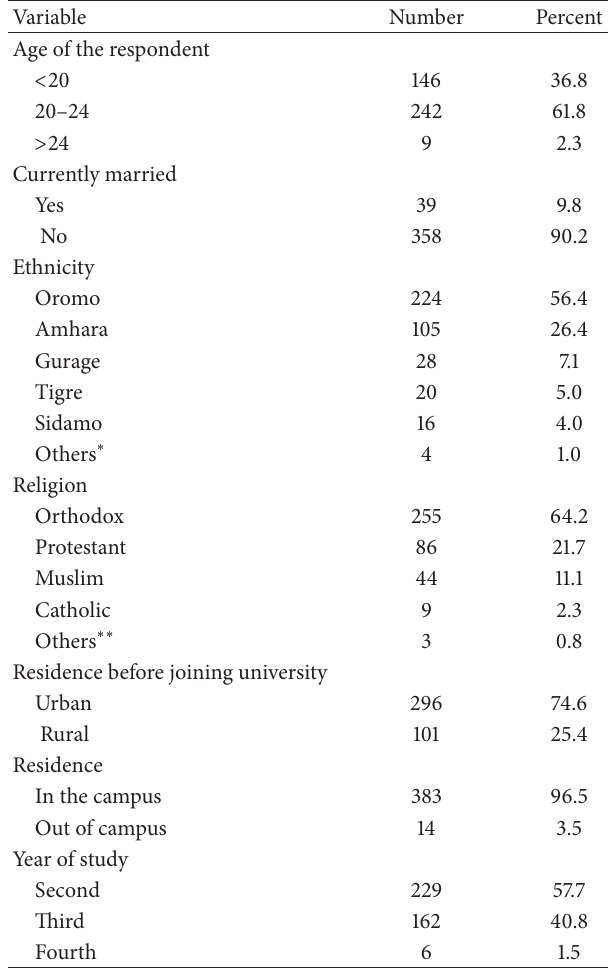
Table 1: Sociodemographic characteristics of the respondents